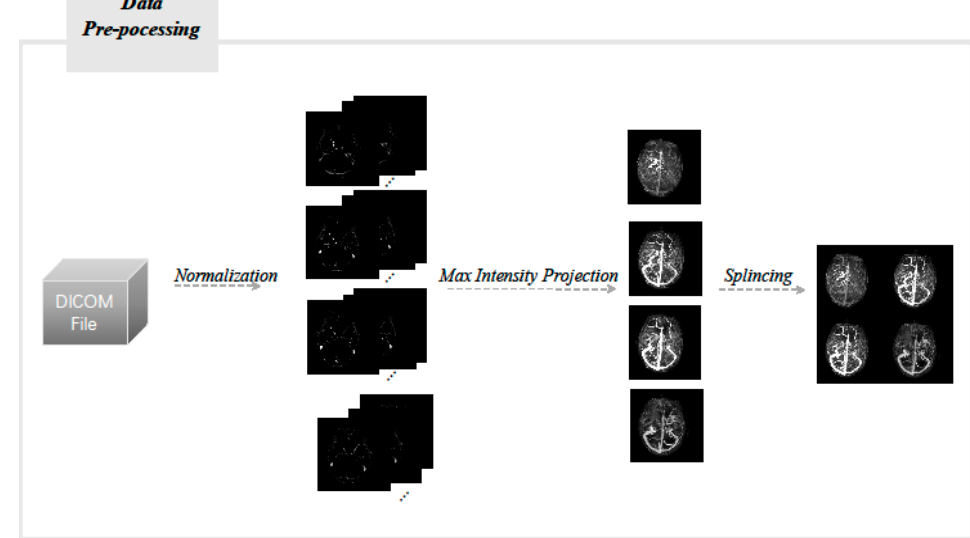
Figure 1. Flow chart of image pre-processing.